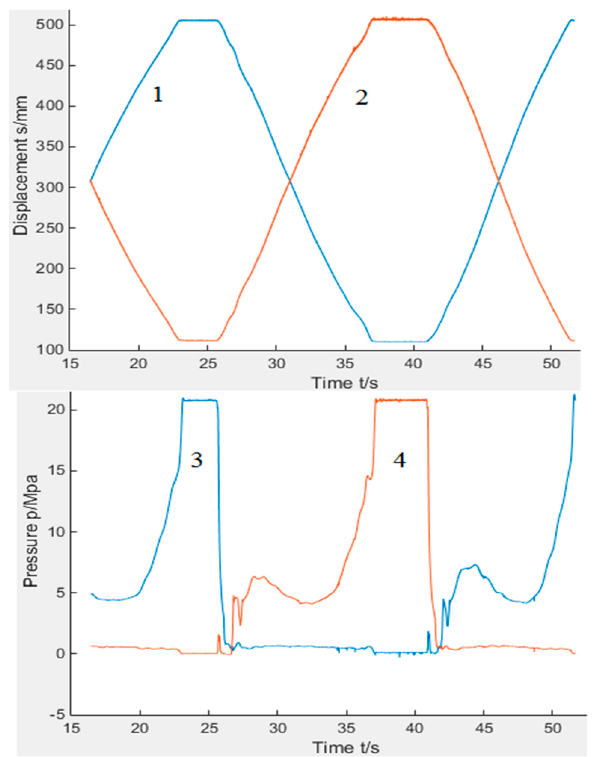
Figure 11. Vehicle test curve. ( 1 ) Left steering cylinder displacement; ( 2 ) right steering cylinder displacement; ( 3 ) left steering cylinder, no rod cavity pressure; ( 4 ) right steering cylinder, no rod cavity pressure.